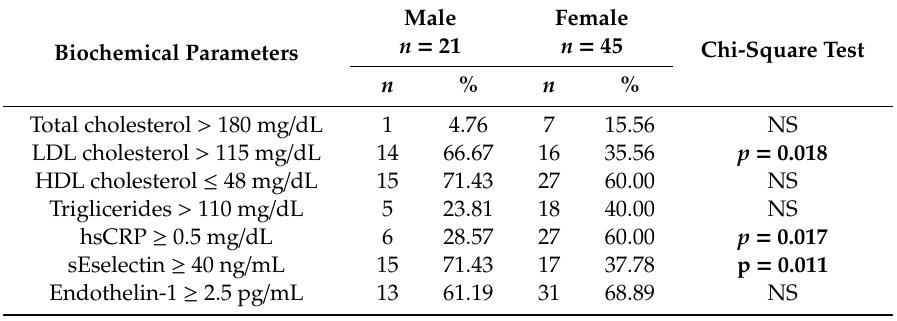
Table 7. Concentrations of the selected endothelial dysfunction markers and lipid metabolism parameters in the patients with RP in relation to gender.